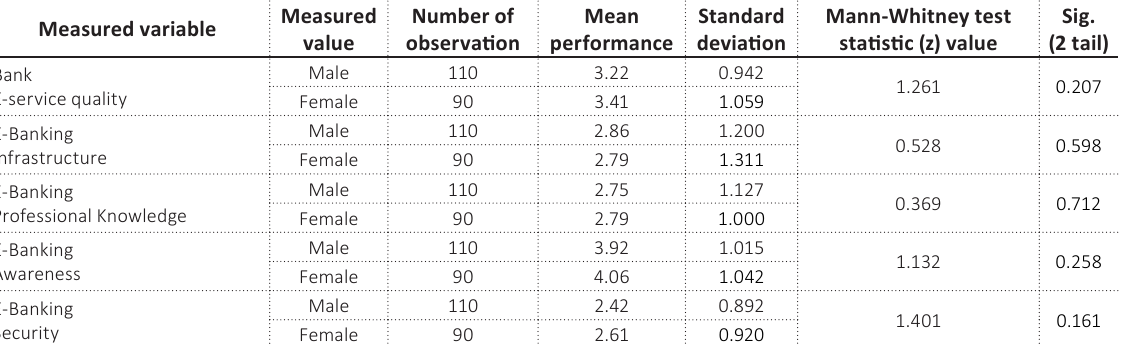
Table 3. Mann-Whitney test for